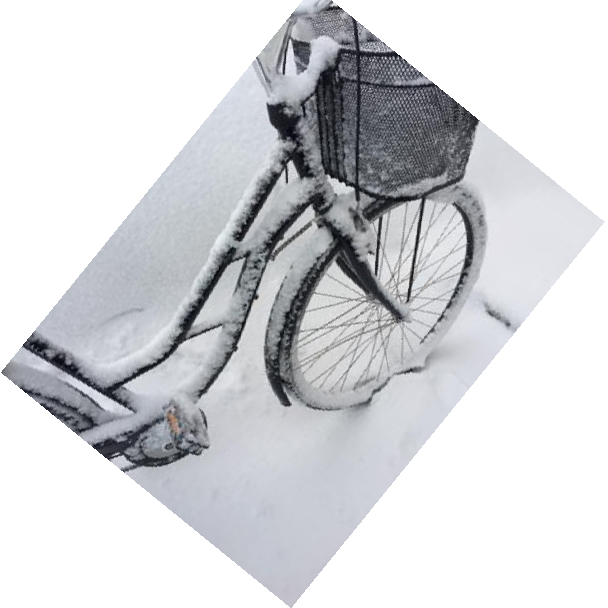
Figure 5. “My bike has been outside all night, despite this I really want to take the bike to school; it is much faster than walking, more fun and you get exercise as well. The picture makes me proud and satisfied that I have accomplished going on this bike every day to school, even though I have 3 km one way, this way I have contributed to a better environment” Josefine C22.